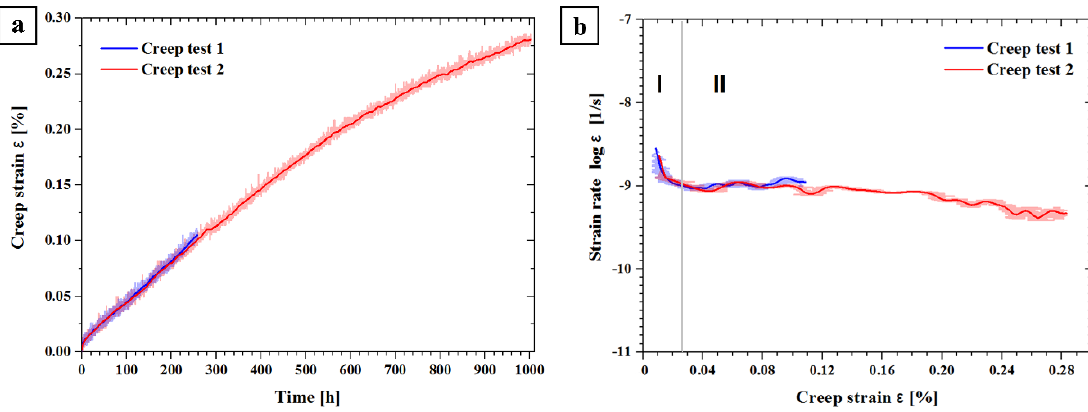
Figure 4. ( a ) Creep strain vs. time; and ( b ) strain rate vs. creep strain with creep stage I (primary) and II (secondary).